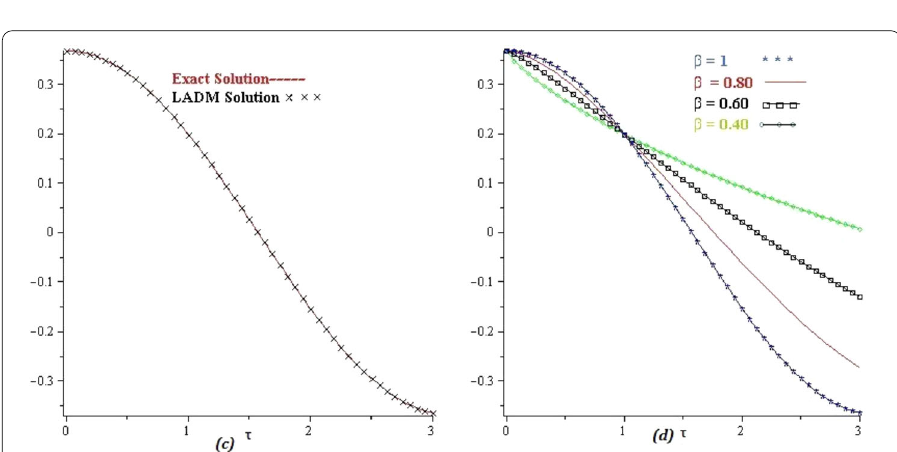
Figure 6 ( c ) Exact and ( d ) LADM solution of v for different values of β of Example